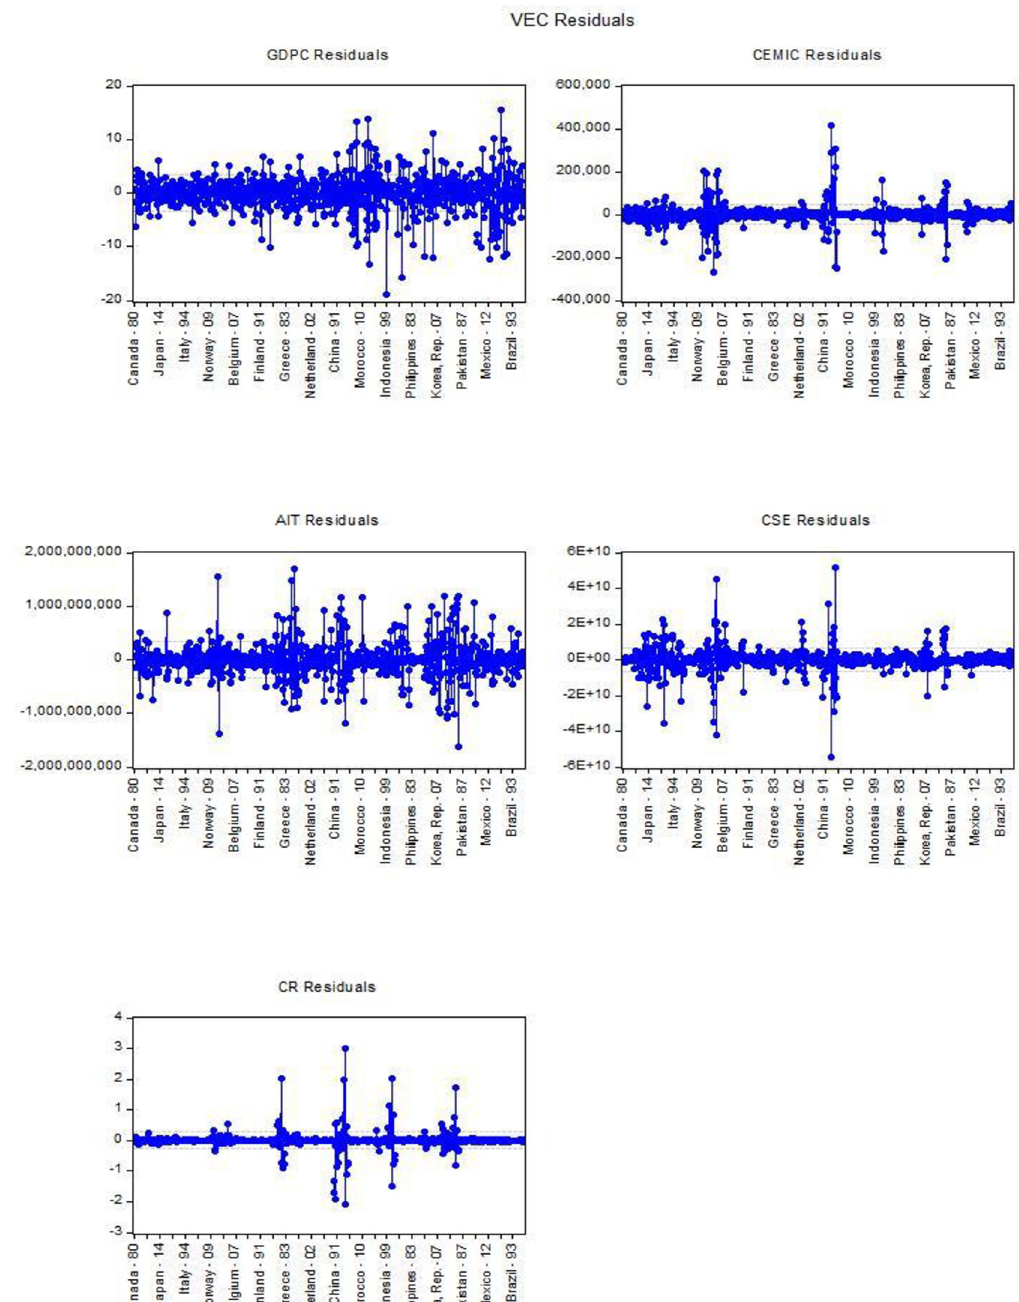
Fig 6. VEC residuals by states. Source: Authors’ amplification.